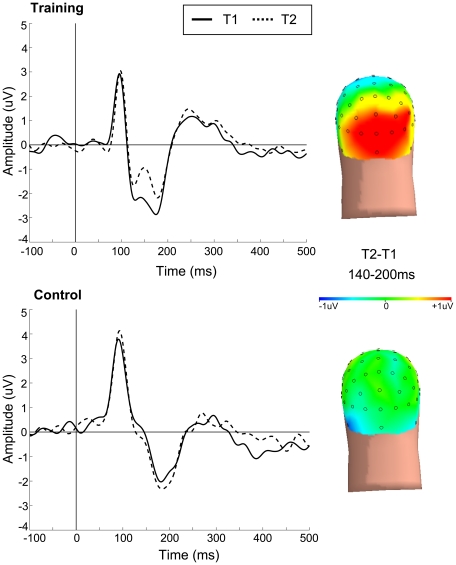
EEG Recordings.Event-Related Potentials during stimulus encoding. Posterior occipital N1 amplitude (120–220 ms) significantly decreased at T2 for the training, but not control group. Statistics are based on electrode of interest (EOI) clusters selected for each participant. Scalp topographies of T2-T1 at the latency of mean N1 peak +/− 1sd illustrate the location of the training related functional plasticity.